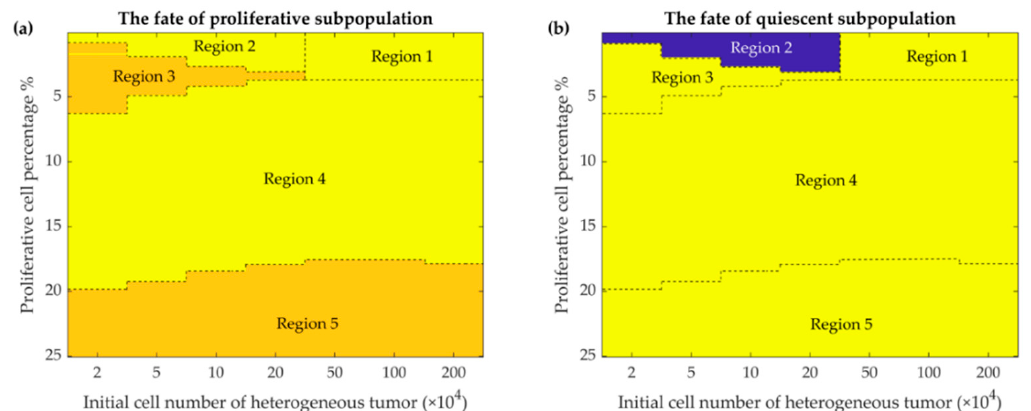
Figure 5. Phase maps of the fate of the two subpopulations present in the heterogeneous tumor after 365 days. The fate of the proliferative ( a ) and quiescent ( b ) subpopulations depends on the percentage of initially present proliferative cells (up to 25 percent are shown) in the different initial tumor cell populations (from 2 × 10 4 to 2 × 10 6 cells). Color-coded events: blue, dormancy; yellow, escape; orange, elimination events (See discussion for further details).